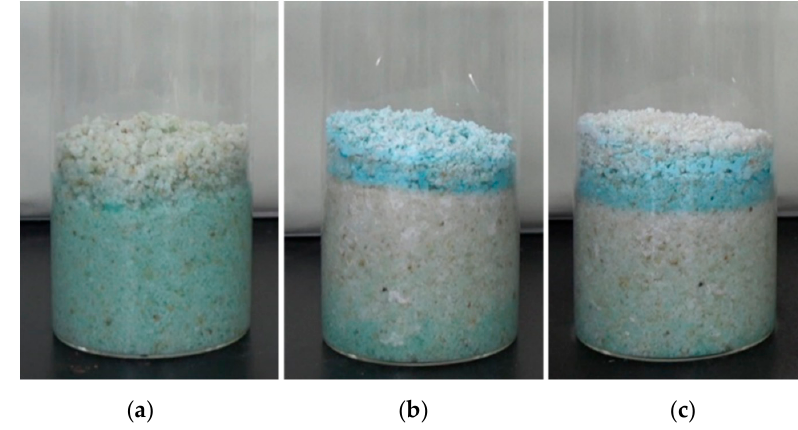
Figure 13. Sample changes at different drying–humidification cycle at 80 °C. ( a ) untreated; ( b ) after 1 cycle; ( c ) after 4